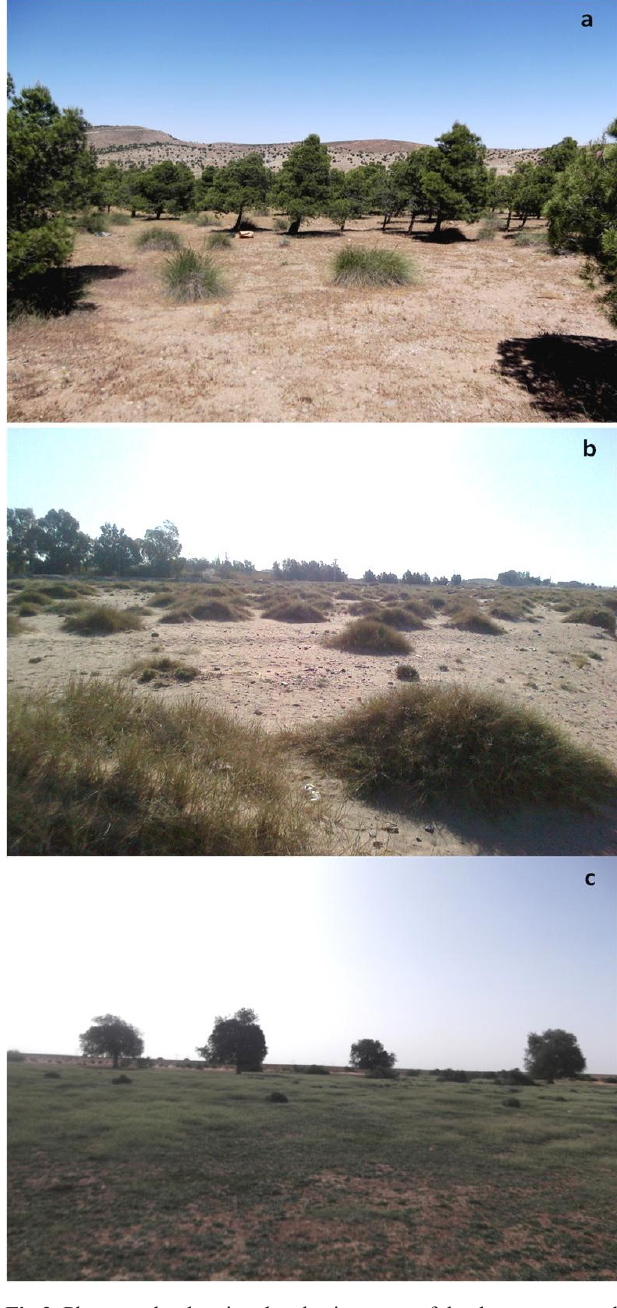
Fig 2. Photographs showing the physiognomy of the three prospected stations (a) Pine forest, (b) Dry River and (c)